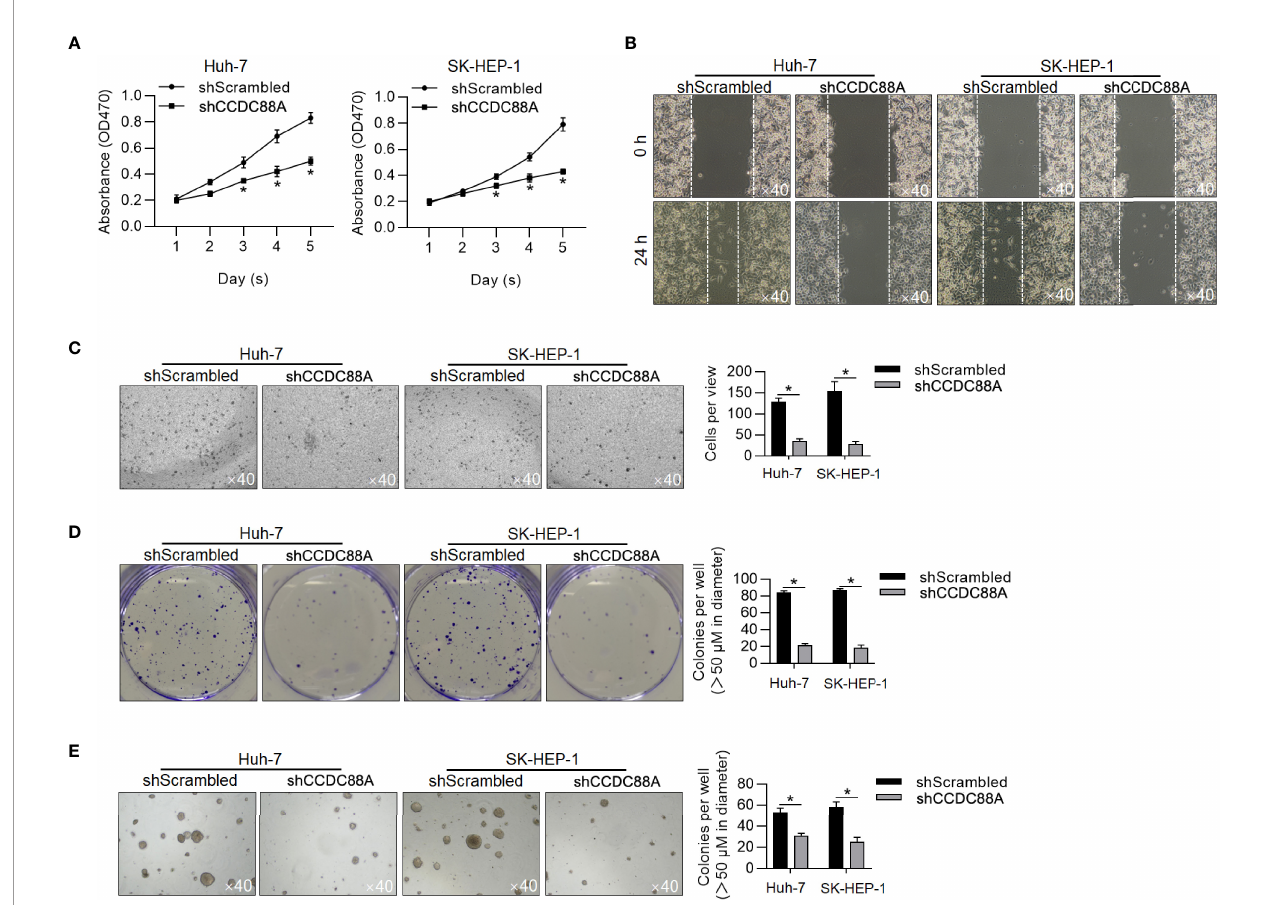
FIGURE 5 | Knockdown of CCDC88A inhibits malignant behaviors in Huh-7 and SK-HEP-1 cells. After 48-h transfection, malignant behaviors of Huh-7 and SK- HEP-1 cells were detected, including cell viability (A) , migration (B) , invasion (C) , colony formation (D) , and tumor formation in soft agar (E) . *P < 0.05, vs. shScrambled